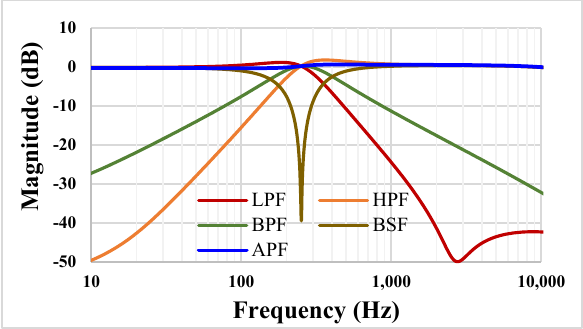
Figure 8. The frequency characteristics of the VM filter.